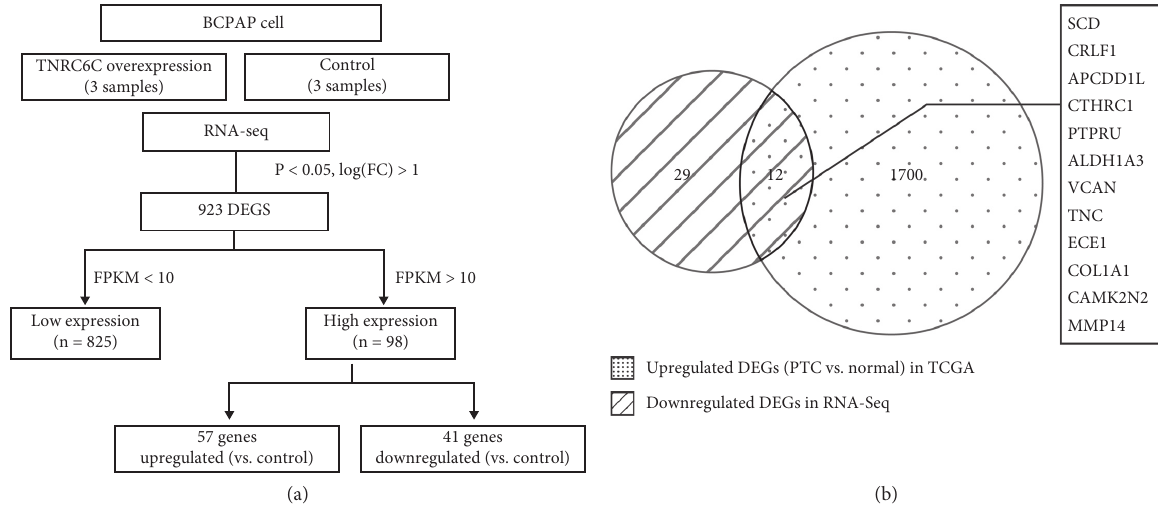
Figure 4: Identification of potential target genes of TNRC6C using RNA-seq. (a) 923 differential gene were identified by differential gene expression analysis in TNRC6C overexpressed BCPAP cells compared with control cells. (b) Venn chart of the DEGs downregulated by TNRC6C overexpression in RNA-seq and DEGs upregulated in PTC compared with noncancerous tissues in TCGA datasets. The DEG was defined as P < 0 . 05, |Log 2 FC| >